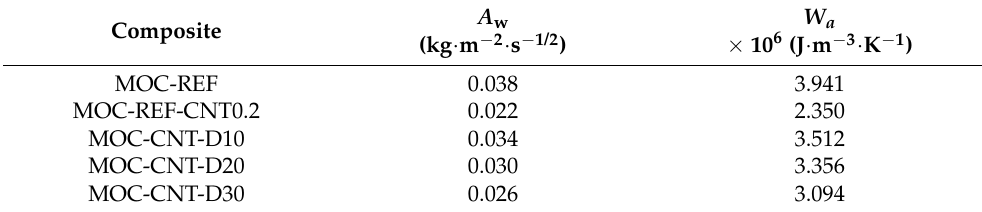
Table 6. Hygric properties of 28 days matured